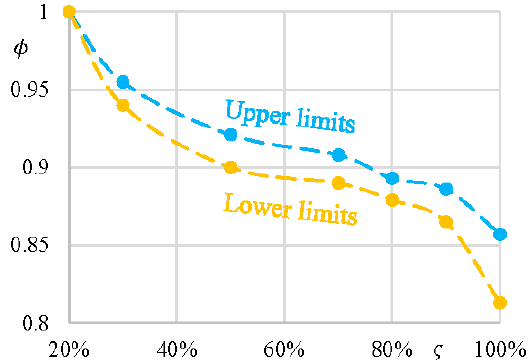
Figure 5. Variations of 𝜙 along the radius from measurements.